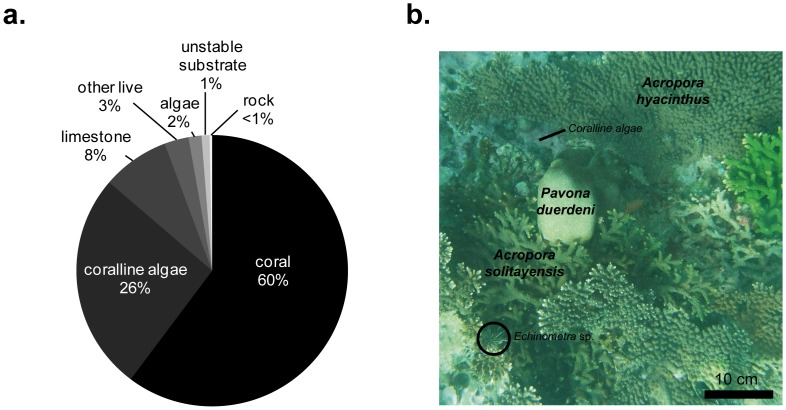
Benthic community. a.Percentage cover of major benthic categories. b. Appearance of coral community at Tatsukushi dominated by Acropora spp (at 5 m in depth).